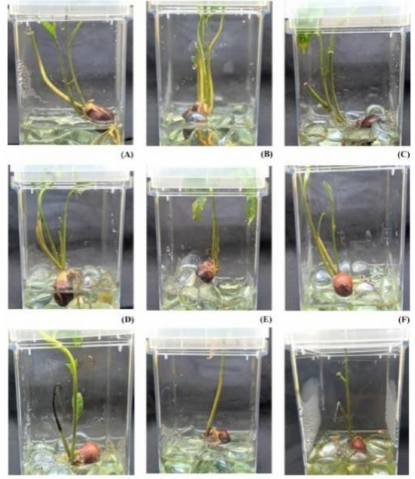
Figure 1. Experiment setup for Salicylic acid (SA) stress induction in A. polystachya seedlings ( A ) Seedling in 10 mM SA stress at Day 2. ( B ) Seedling in 10 mM SA stress at Day 4. ( C ) Seedling in 10 mM SA stress at Day 6. ( D ) seedling in 50 mM SA stress at Day 2. ( E ) Seedling in 50 mM SA stress at Day 4. ( F ) Seedling in 50 mM SA stress at Day 6. ( G ) Seedling in 100 mM SA stress at Day 2. ( H ) Seedling in 100 mM SA stress at Day 4. ( I ) Seedling in 100 mM SA stress at Day